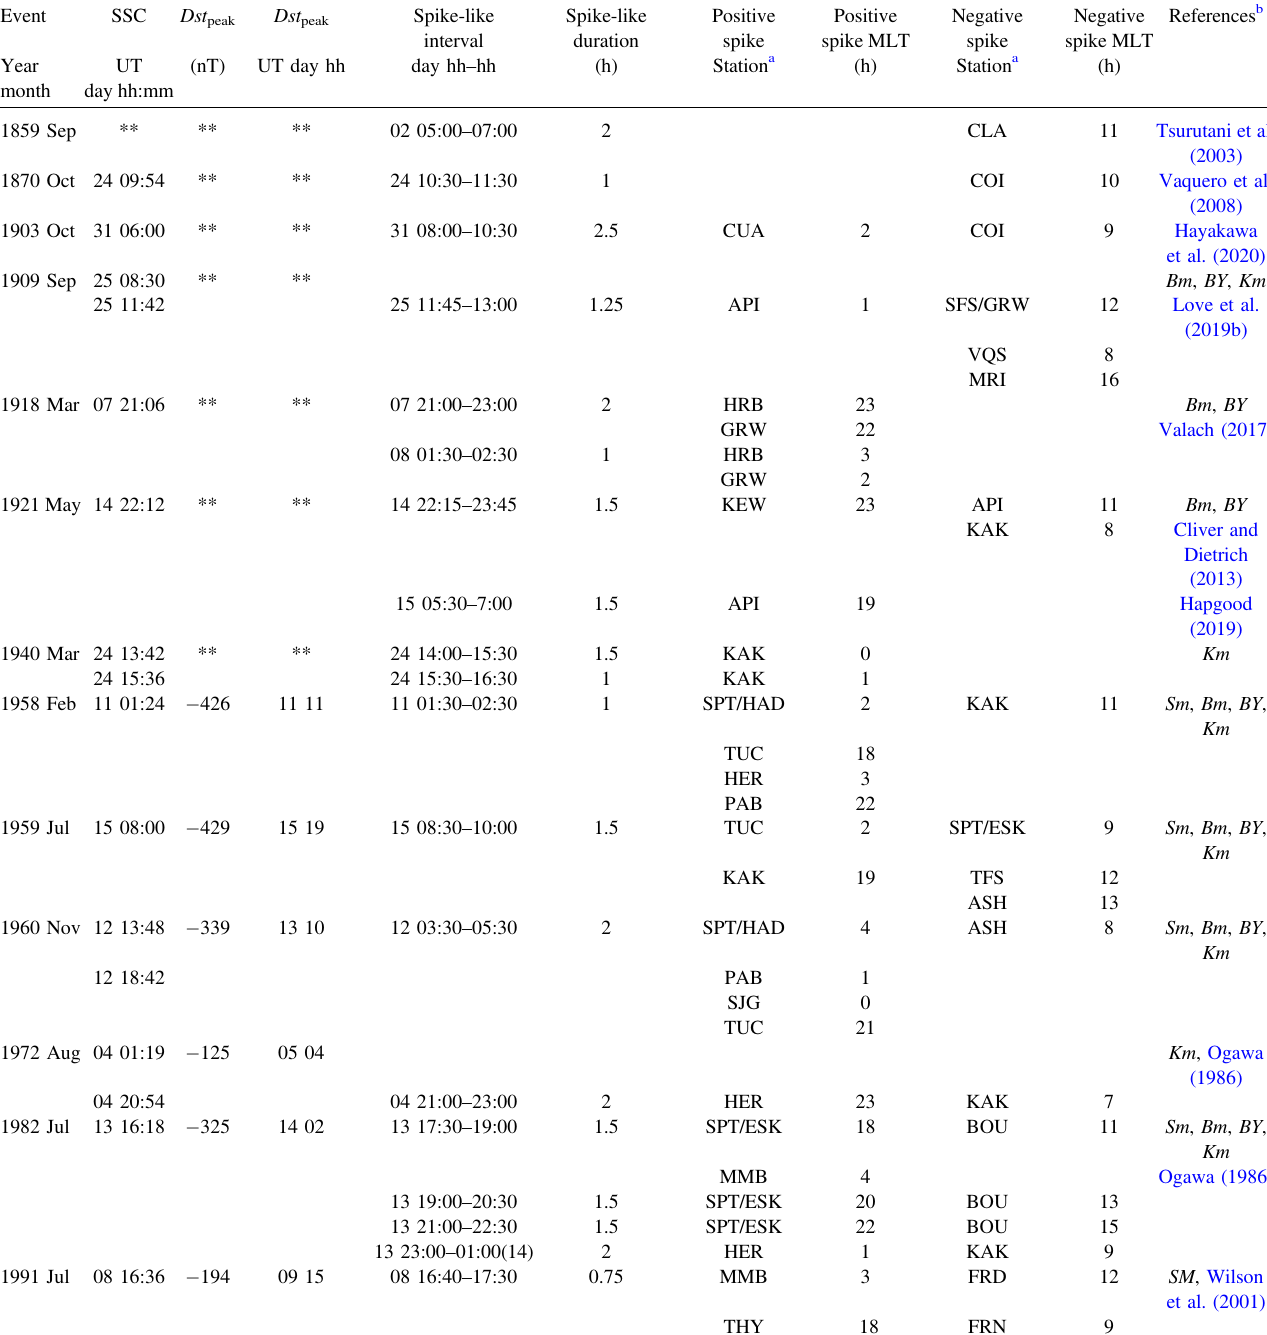
Table 1. List of historic events (location information is given in Appendix